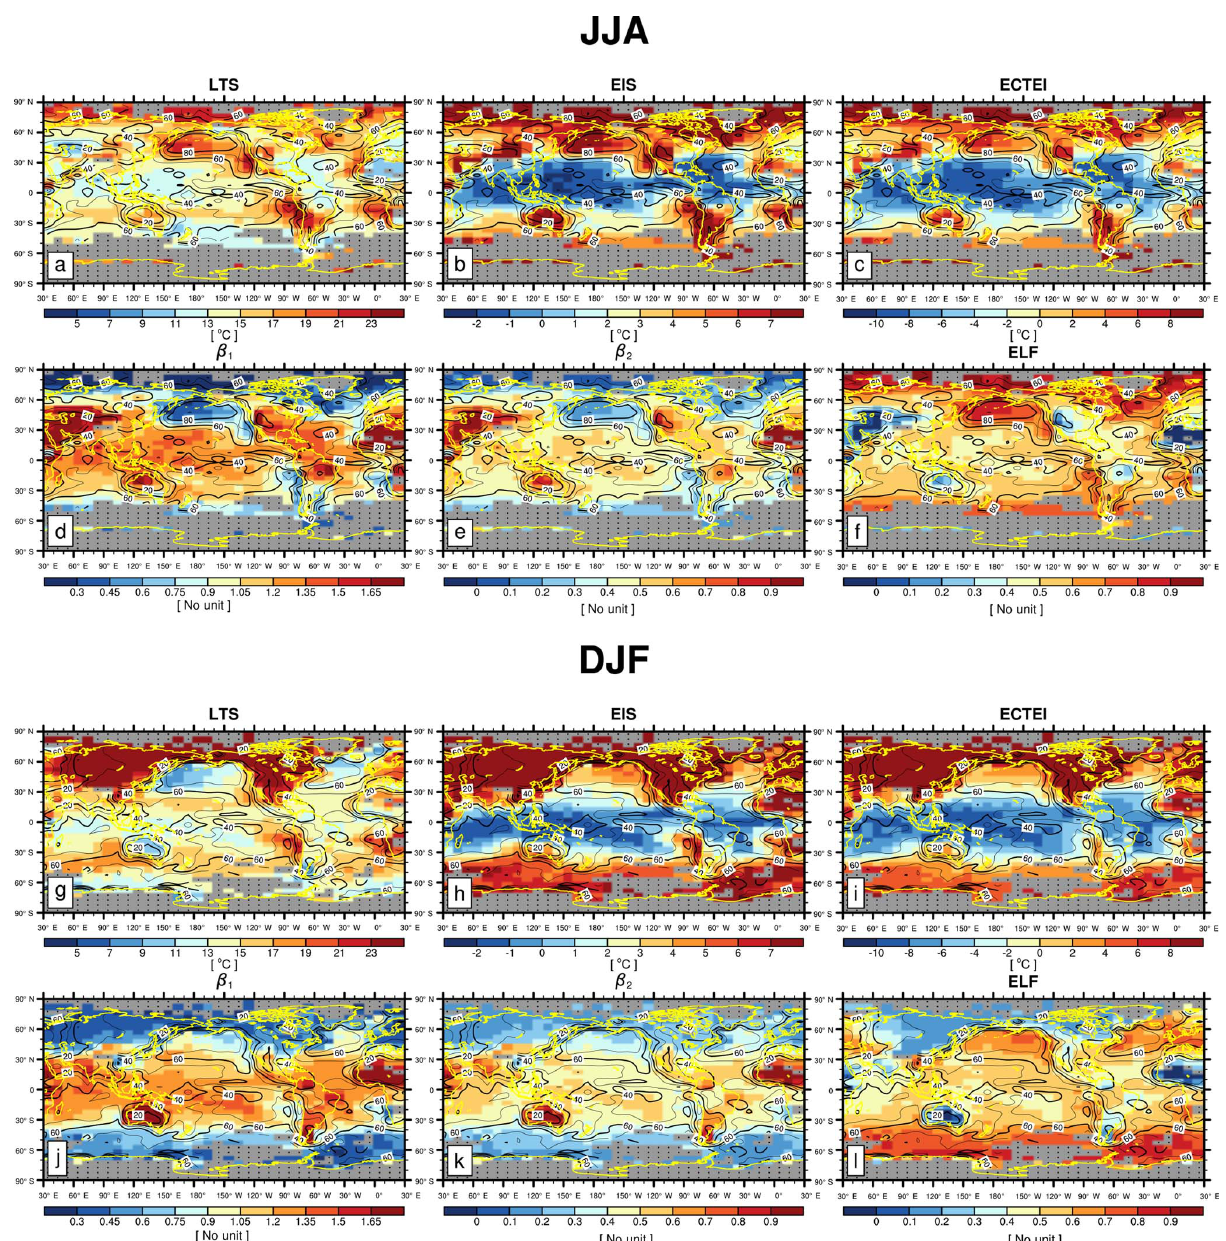
Figure 11. Global distribution of climatological LTS, EIS, ECTEI, β 1 , β 2 , and ELF during JJA (upper) and DJF (lower), respectively. The contour line denotes the climatological seasonal LCA reported by surface observers. These figures are the same as Figs. 3 and 4 but were obtained from the analysis of all observation data (i.e., 0 < α < 1, α = 0, and α =